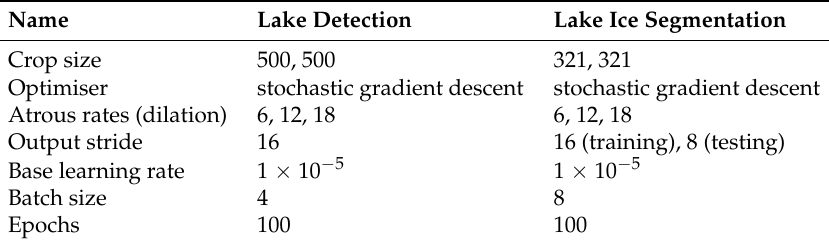
Table 13. Hyperparameters for the Deep-U-Lab model.